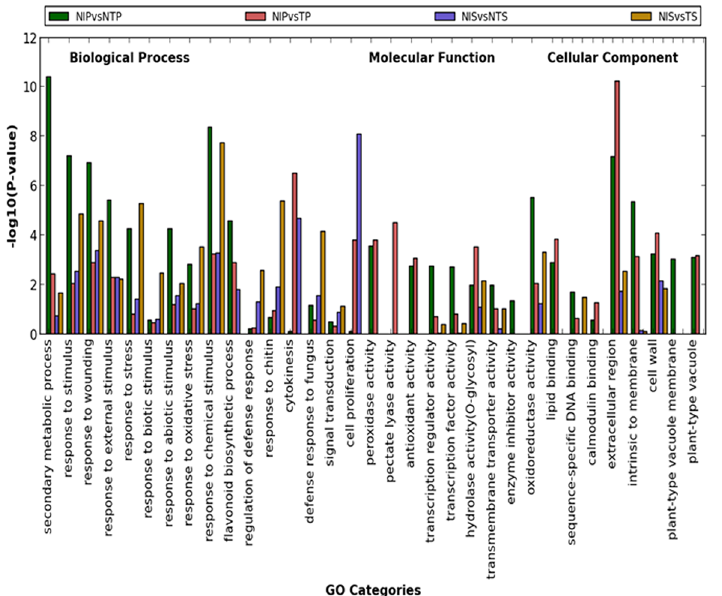
Fig 6. Gene ontology enrichment analysis of DEGs in pericarp and seed tissues of cotton in response to infection with atoxigenic and toxigenic strains of A . flavus . The X-axis represents the GO categories and Y-axis represents enrichment in terms of